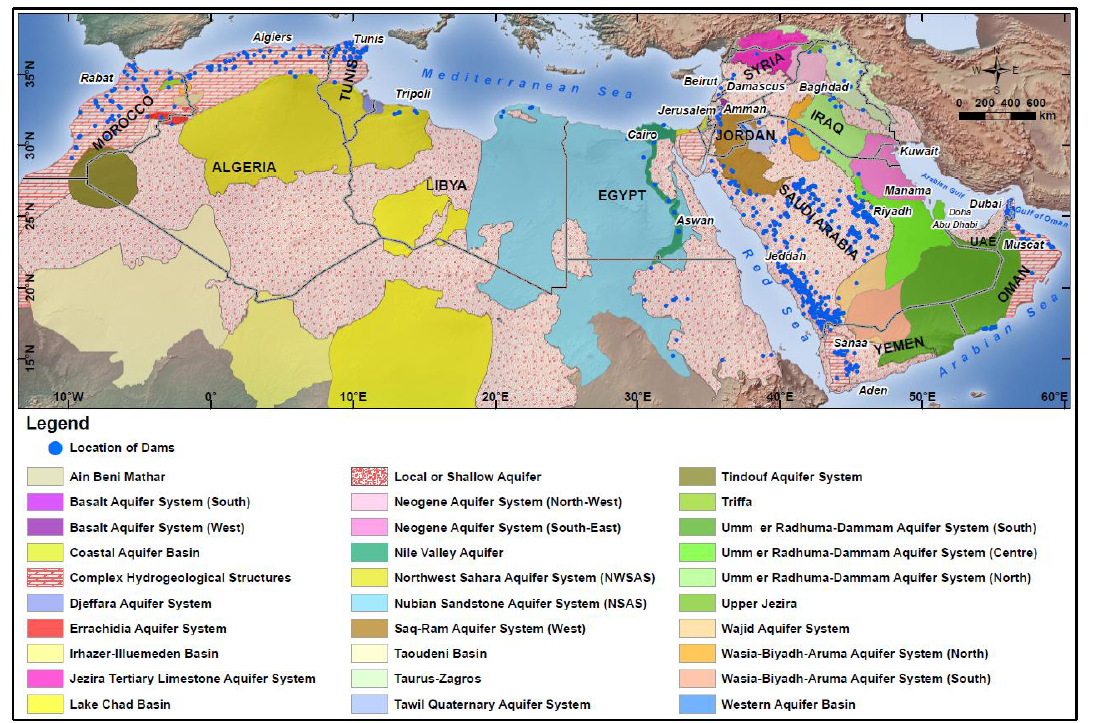
Figure 3. Simplified hydrogeological map of the MENA region. Locations of major dams are shown (data source: [68]).